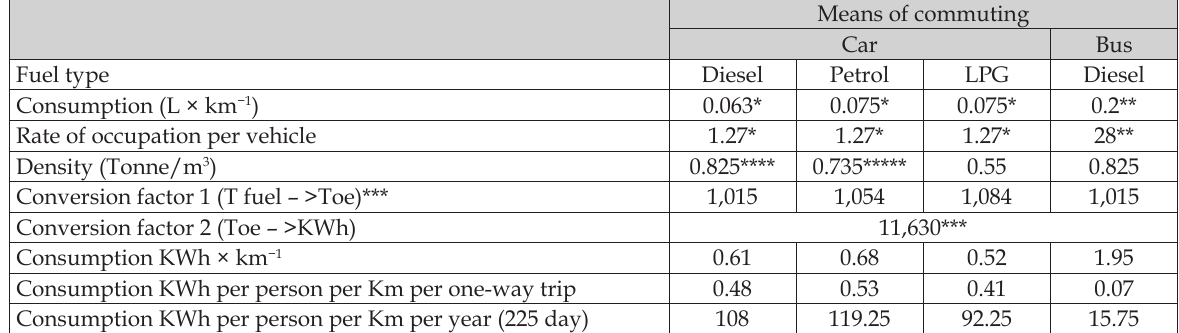
Table 3. Fuel conversion to kWh per km per person.